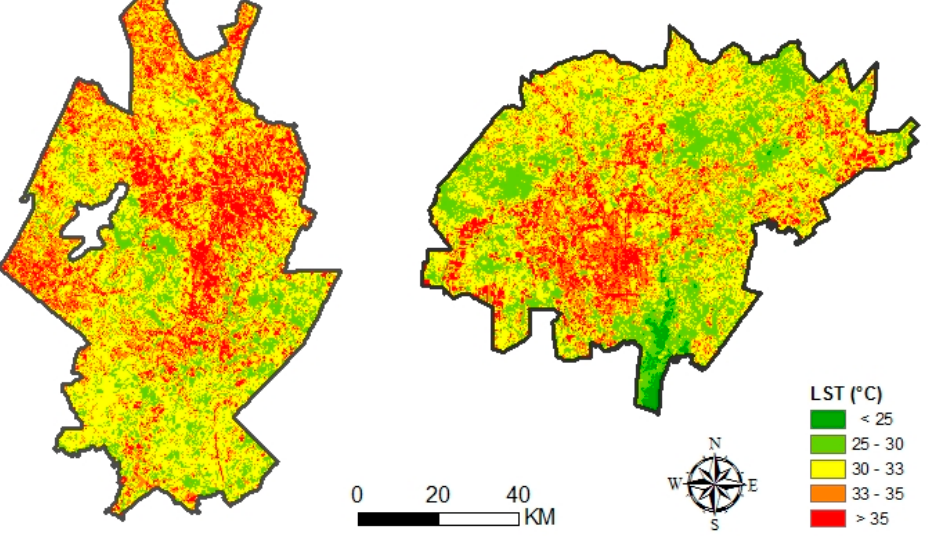
Figure 4. Overall spatial variation of the and surface temperature (LST) for the SUHIs of Austin ( left ) and San Antonio ( right ) metropolitan areas on 20 July 2015.